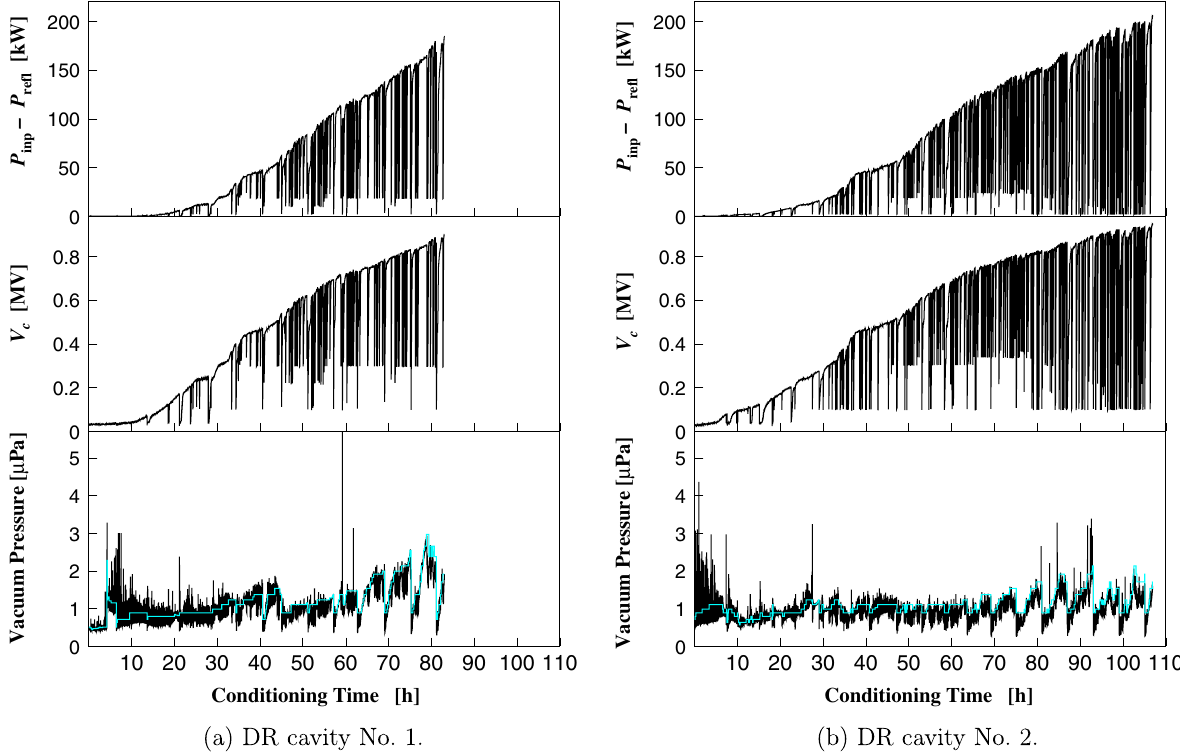
FIG. 7. Conditioning histories until V c reached (a) 0.90 MV for DR cavity No. 1 and (b) 0.95 MV for DR cavity No. 2 with data points recorded every 10 s. Data with no input rf power, data while the input rf power was kept constant, and data used to tune the control system or klystron are excluded here. The light blue lines indicate the reference vacuum pressure specified in the automatic conditioning by computer control. If the vacuum pressure is higher than the reference pressure, the rf power is stepped down until the vacuum pressure becomes lower than the reference pressure, and then the power is gradually stepped up as long as the vacuum pressure is lower than the reference pressure. The step-up slope is proportional to the difference between the reference and vacuum